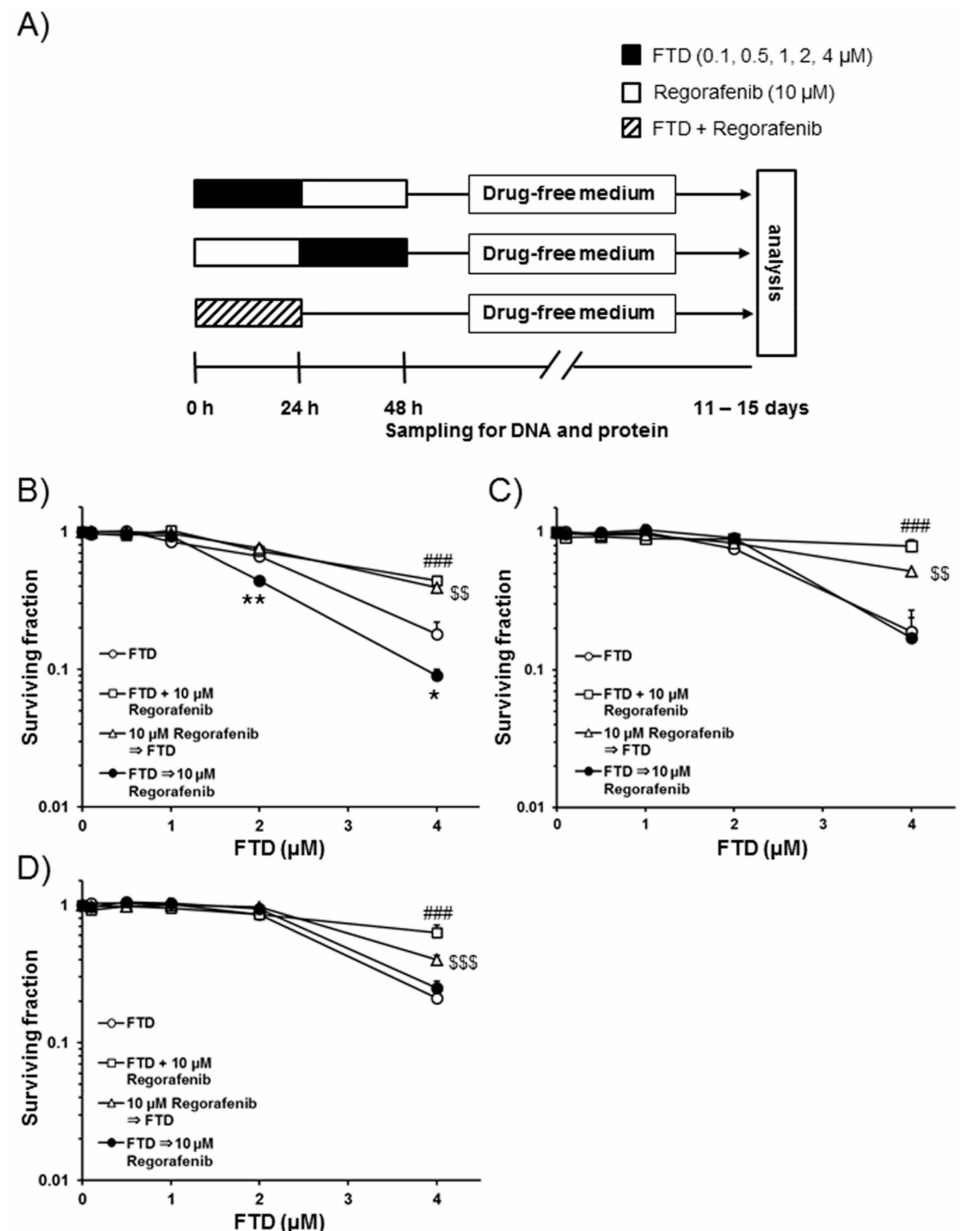
Figure 1. A clonogenic cell survival assay of trifluridine (FTD) and regorafenib using various treatment schedules in SW620, HCT 116, and HT-29 cells. ( A ) Treatment schedules are shown. Cells were plated at appropriate concentrations in duplicate in six-well plates. SW620 ( B ), HCT 116 ( C ), and HT-29 ( D ) cells were exposed to 0.1–4.0 µ M FTD alone, in combination with 0.1–4.0 µ M FTD and 10.0 µ M regorafenib for 24 h, 0.1–4.0 µ M FTD for 24 h followed by 10.0 µ M regorafenib for 24 h, or 10.0 µ M regorafenib for 24 h followed by 0.1–4.0 µ M FTD for 24 h. Eleven to fifteen days after removal of the drug, the number of colonies was determined. Data from three independent experiments are presented as the mean + standard deviation (SD); surviving fraction (SF) in 0.1–4.0 µ M FTD followed by 10.0 µ M regorafenib or regorafenib followed by FTD was calculated by assuming a SF of 1.0 when cells were treated with 10.0 µ M regorafenib alone for 24 h. Mean SF values for the sequential combination of 2.0 or 4.0 µ M FTD followed by 10.0 µ M regorafenib in SW620 cells are shown. * p < 0.05 and ** p < 0.01 represent significant differences compared with 2.0 or 4.0 µ M FTD alone. ### p < 0.001, $$ p < 0.01, and $$$ p < 0.001 represent significant differences compared with 4.0 µ M FTD